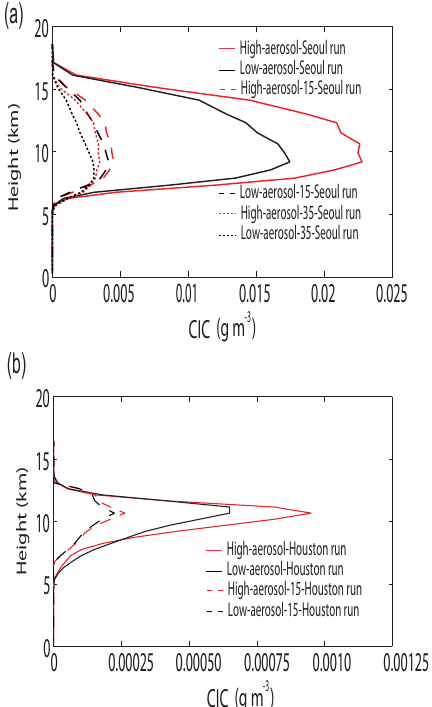
Figure 4. Same as Fig. 3, but for cloud ice content (CIC).